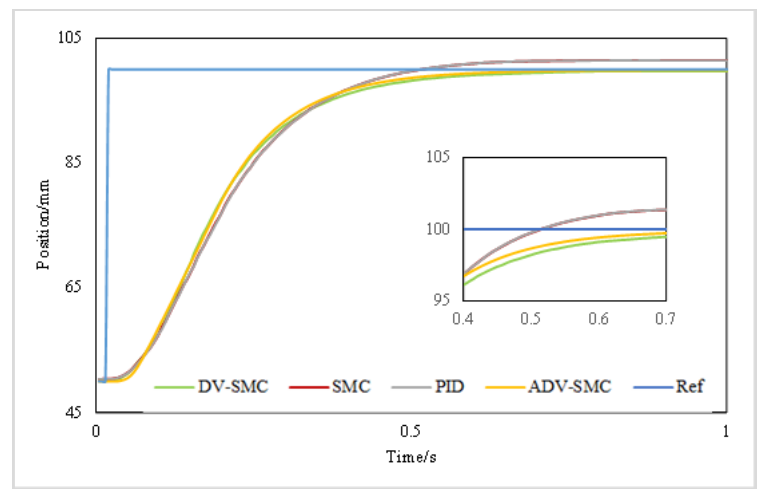
Figure 6. Experimental response to 50 mm step input.